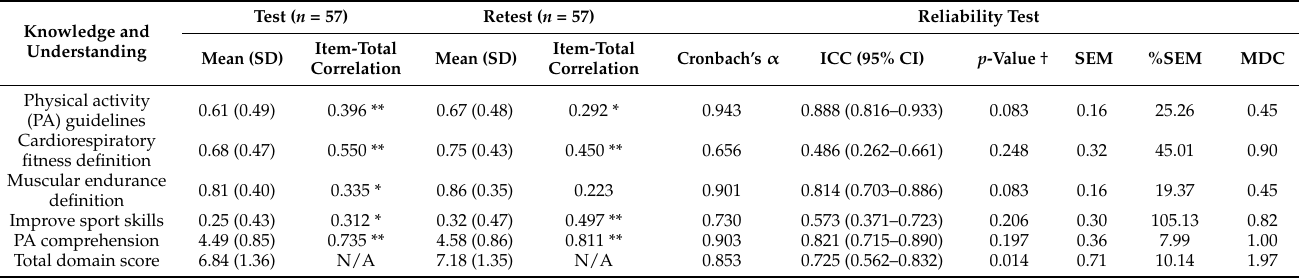
Table 5. Reliability, test–retest and systematic differences of knowledge and understanding questions from CAPL-2 battery